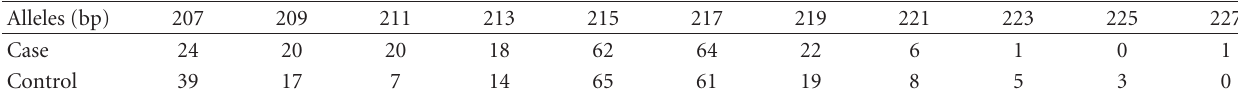
Table 1: Allele frequencies of genotyping of D6S289 in 119 SZ cases and 119 controls from a homogenous population in Shandong peninsula of China. Normal chi-square (T1) = 17 . 89, P = . 047). This was reached 4657 times in 100 000 simulations by clump analysis.